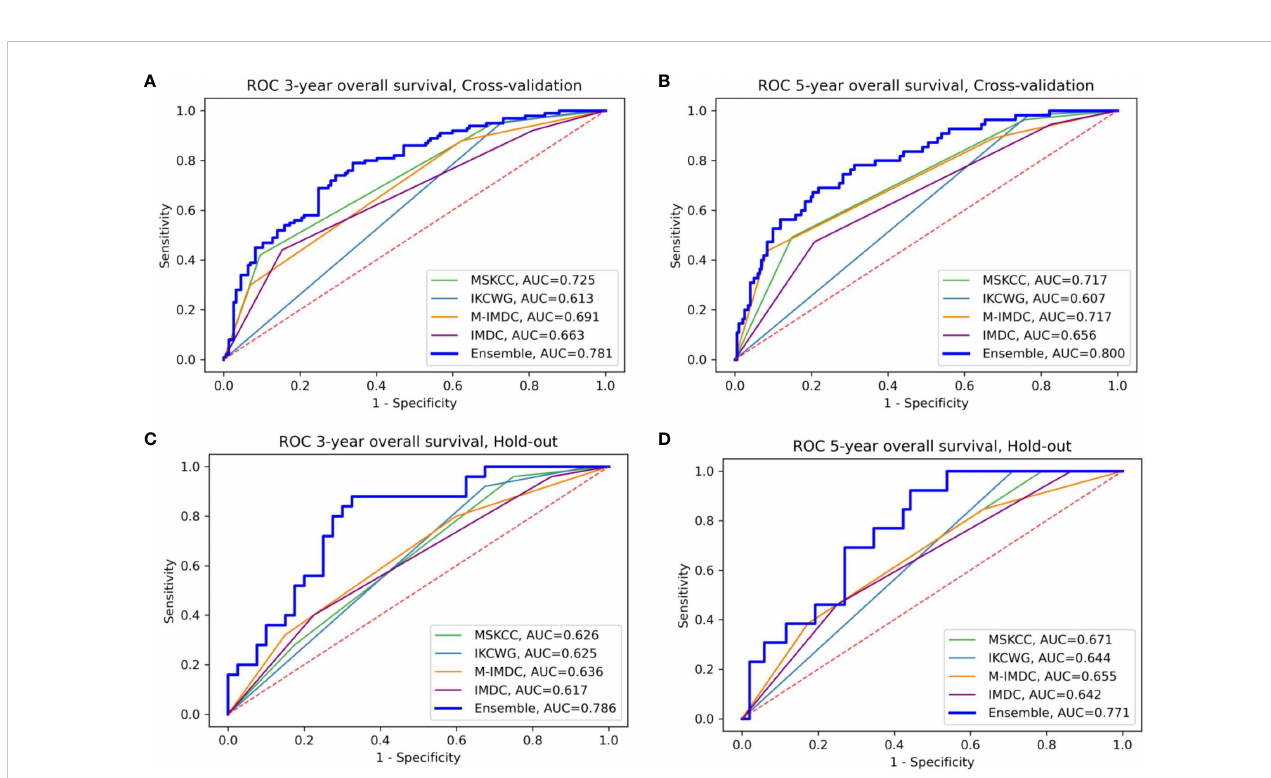
FIGURE 4 Comparison of the ensemble model and four traditional models for OS prediction for three- and fi ve-year survival (A, B) for cross-validation sets (C, D) for the hold-out set, respectively. The area under the curve (AUC) of the ensemble model is higher than all traditional models in the four presented settings; M-IMDC stands for Modi fi ed IMDC.